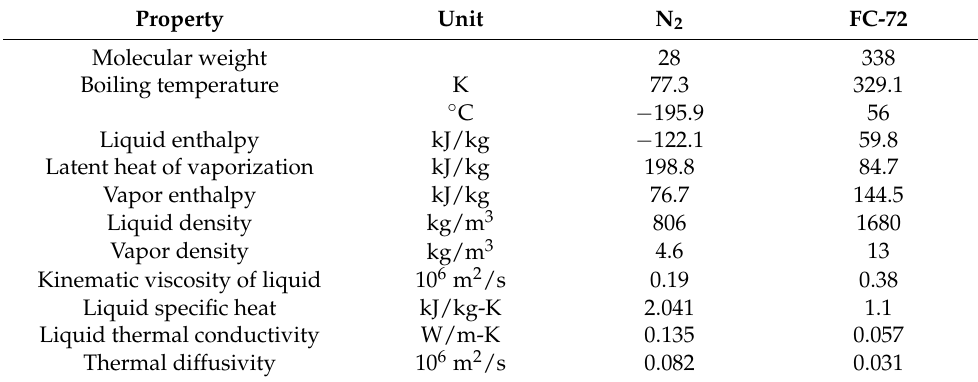
Table 1. Descriptions of N 2 and FC-72’s properties